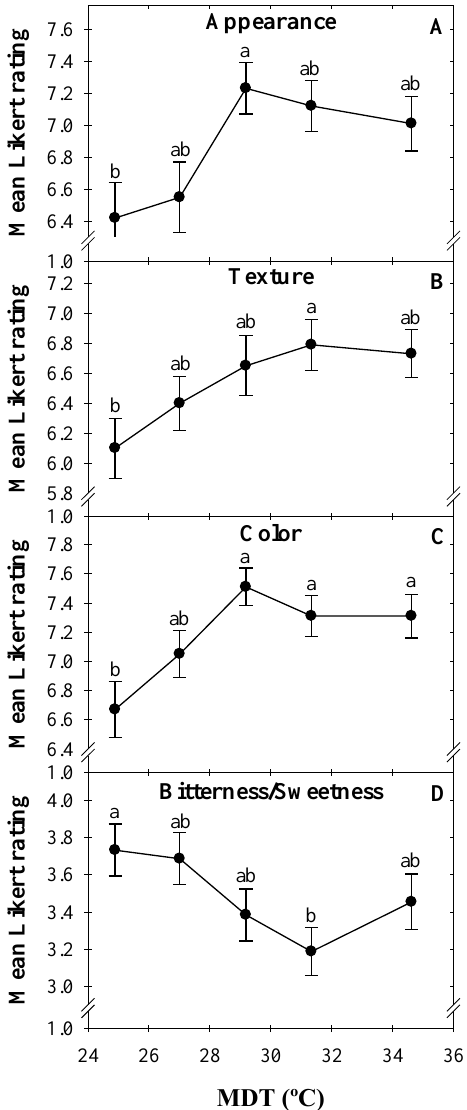
Figure 2. Consumer preference influenced by MDT. Appearance ( A ), texture ( B ), color ( C ), and bitter- ness/sweetness ( D ) of sweet basil ( Ocimum basilicum ‘Nufar’) grown at mean daily temperatures (MDT) from 25 to 35 ◦ C for three weeks, based on a 9-point Likert scale ranging from dislike extremely (1) to like extremely (9). Means not followed by the same letter are significantly different by Tukey’s honestly significant difference test ( p < 0.05). Each bar represents 86 responses ± sd.